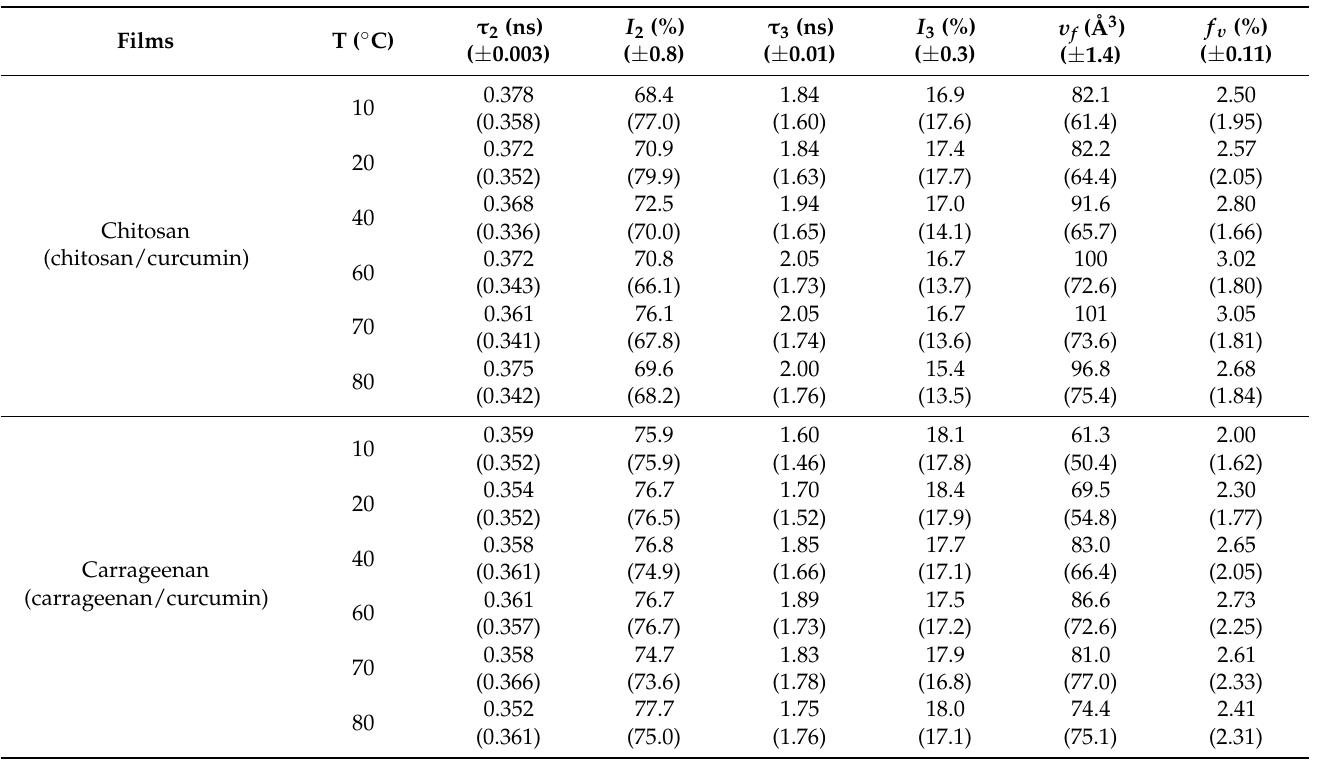
Table 1. PALS parameters as lifetimes ( τ 2 and τ 3 ) and intensities ( I 2 and I 3 ) with free volume hole size ( υ f ) and free volume fraction ( f υ ) in terms of temperature for chitosan, chitosan/curcumin, carrageenan, and carrageenan/curcumin.